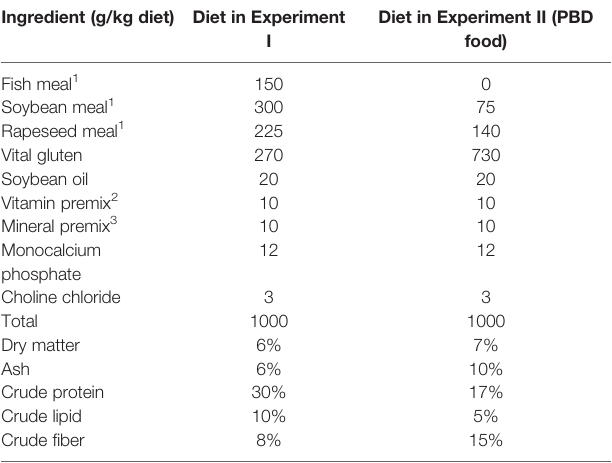
TABLE 1 | Ingredients and chemical compositions of dry food diets (dry matter, g/kg diet). Ingredient (g/kg diet) Diet in Experiment